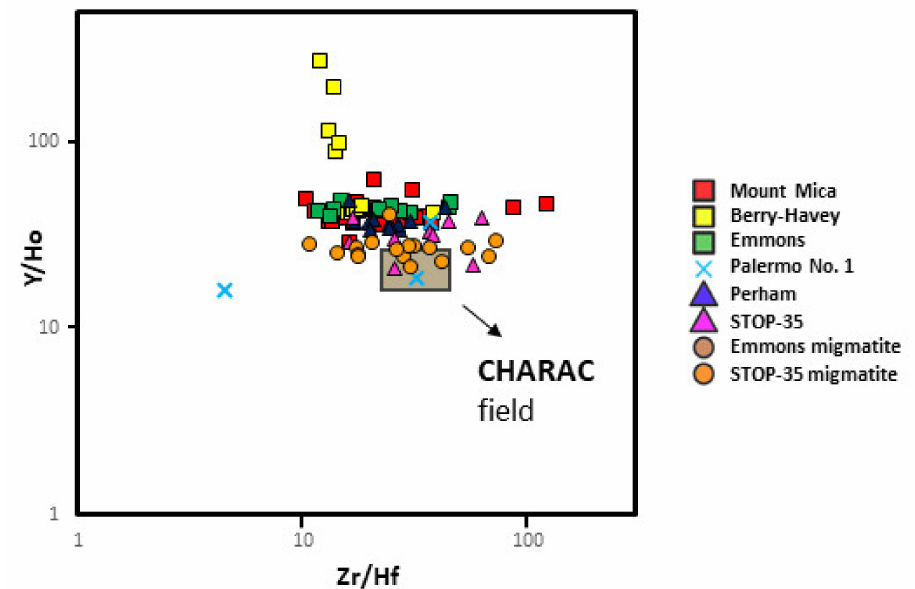
Figure 16. Plot of the values Y/Ho vs. Zr/Hf for the studied garnets. The grey rectangle shows the CHARAC field for evolved magmatic systems as suggested by